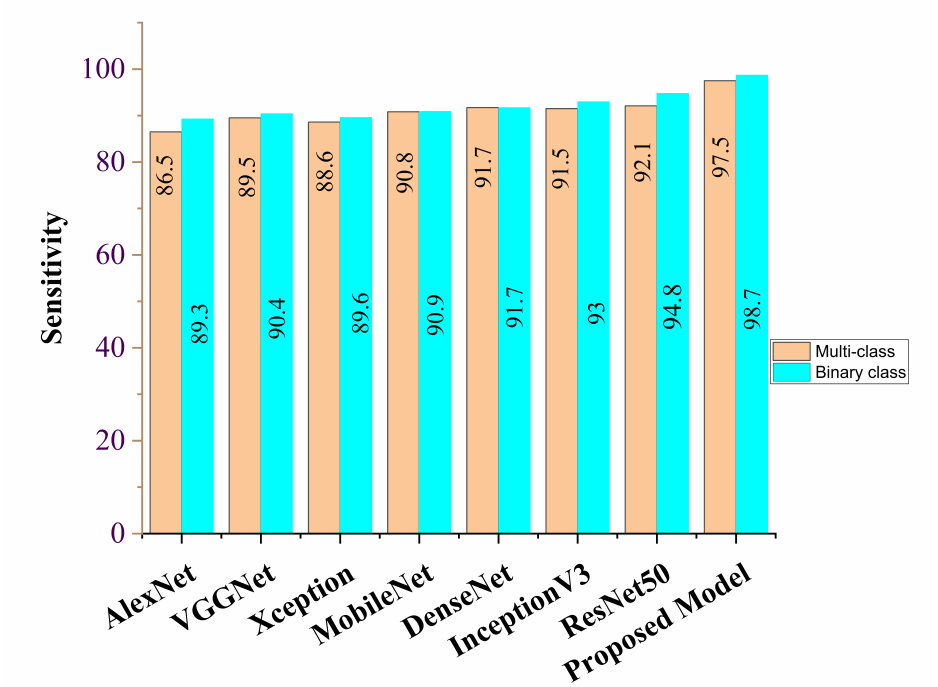
Figure 9. Sensitivity report for our proposed model and selected pre-trained models for binary class and